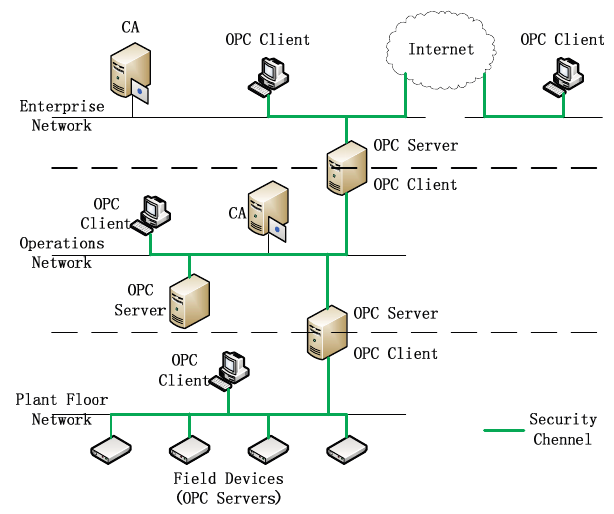
Figure 3. Architecture of security communication model.